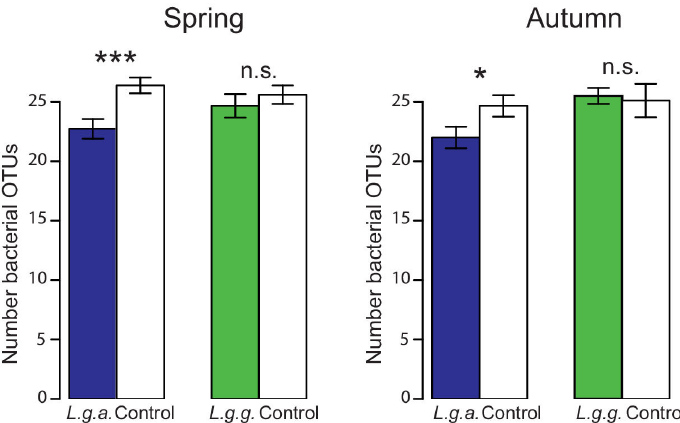
Figure 10. Number of bacterial OTUs in Lamium galeobdolon subsp. argentatum plots, Lamium galeobdolon subsp. galeobdolon plots and corresponding control plots in both spring and autumn. Mean values ± s.e. are shown, n = 18. Di ff erences were tested using paired t -tests; * p < 0.05, *** p < 0.001, n.s. not signi fi cant).